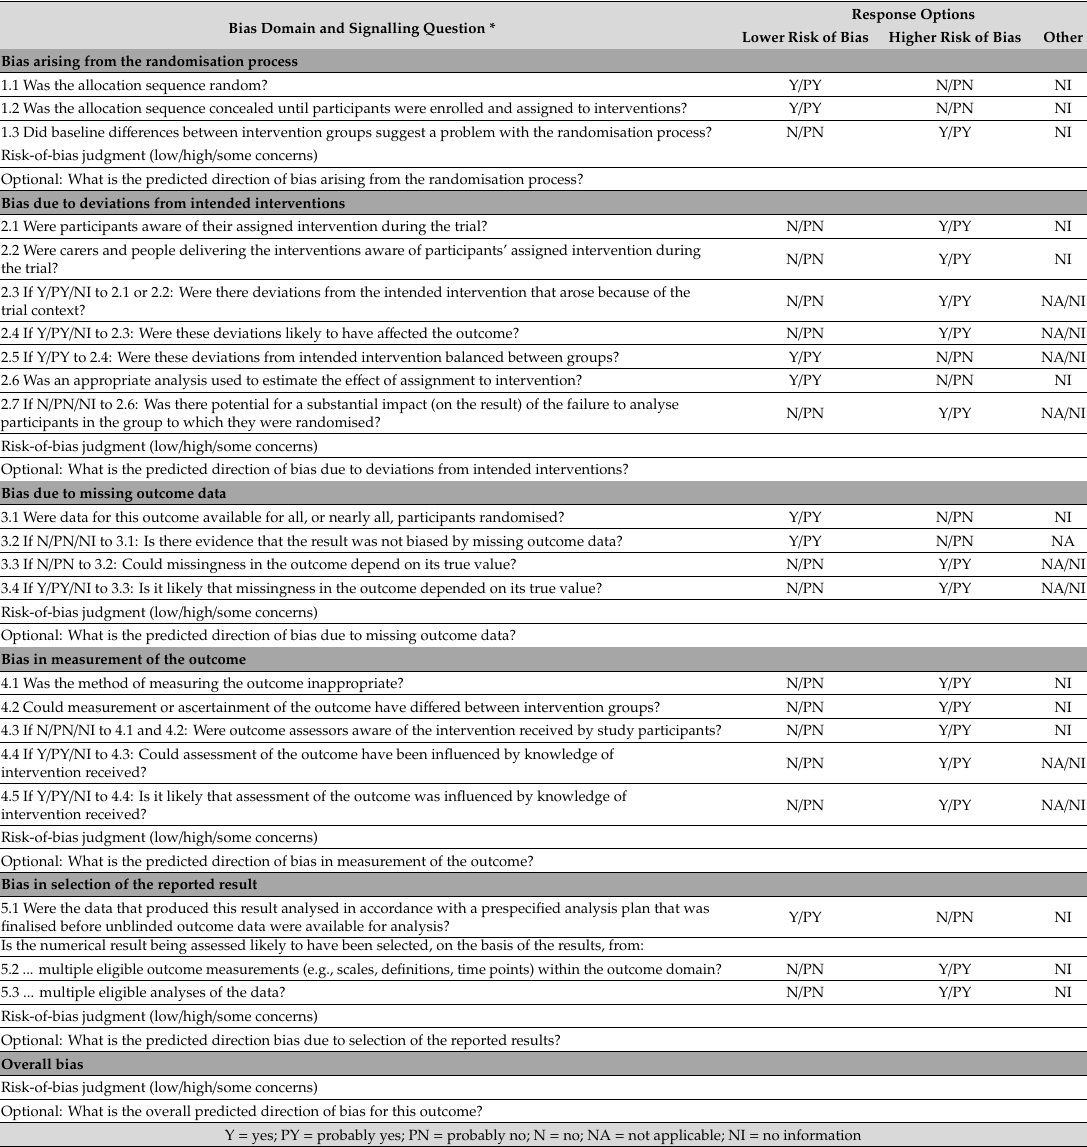
Table A2. Version 2 of the Cochrane tool for assessing risk of bias (RoB 2)